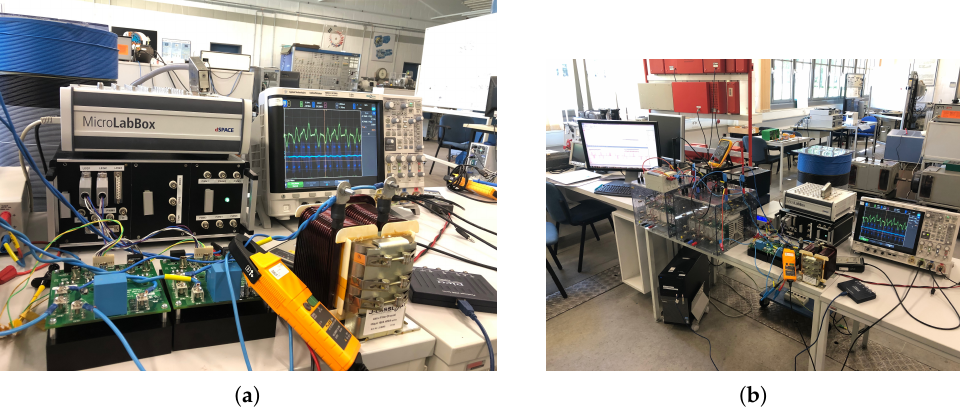
Figure 21. Experimental implementation of the three level asymmetrical topology